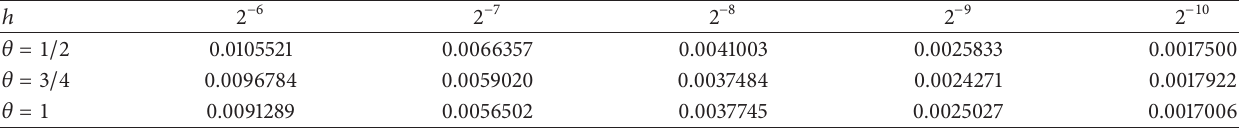
Table 1: The means of absolute errors 𝜖 with 𝑡 𝑁 = 2 of SST (3) for solving SDDE (54).